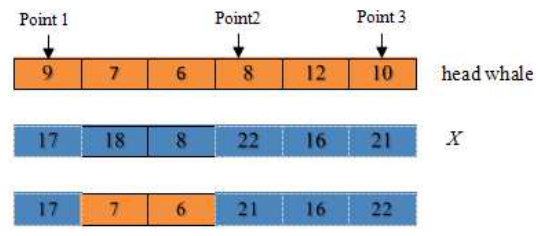
Figure 3. Shrink-wrapped